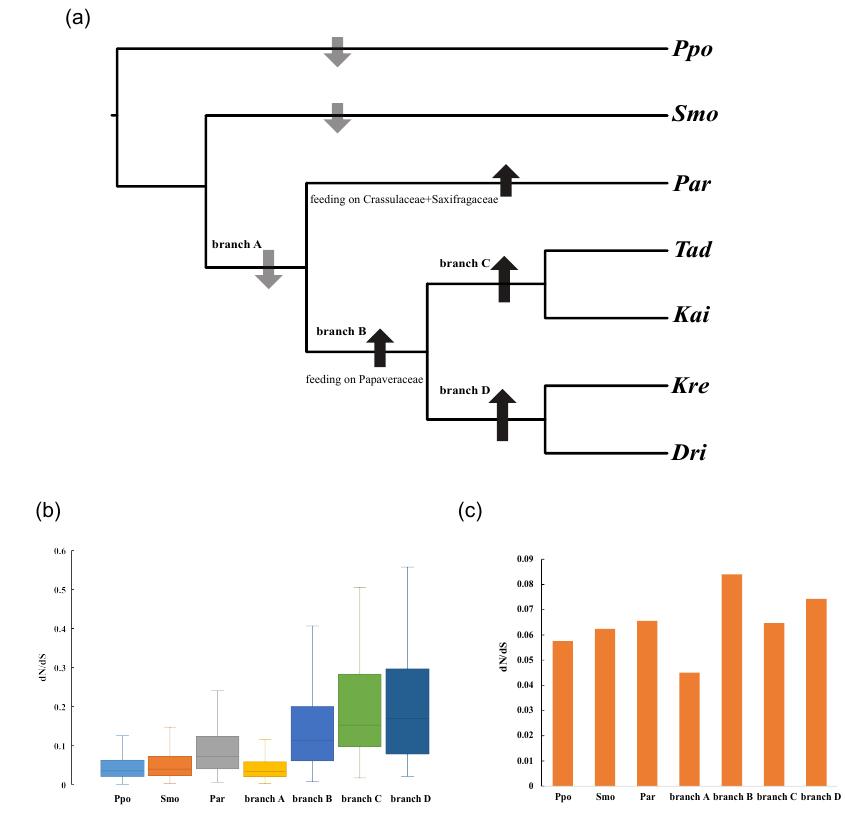
Figure 2. Phylogenetic tree used in this study ( a ) and branch specific ratios of nonsynonymous (dN) to synonymous (dS) substitutions rates (dN / dS ratios) obtained from di ff erent data sets ( b , c ). Arrows in ( a ) indicate decreased or increased dN / dS ratios. The dN / dS ratios for branches were estimated from each ortholog ( b ) and concatenated all orthologs ( c ). Ppo, Papilio polytes ; Smo, Sericinus montelus ;